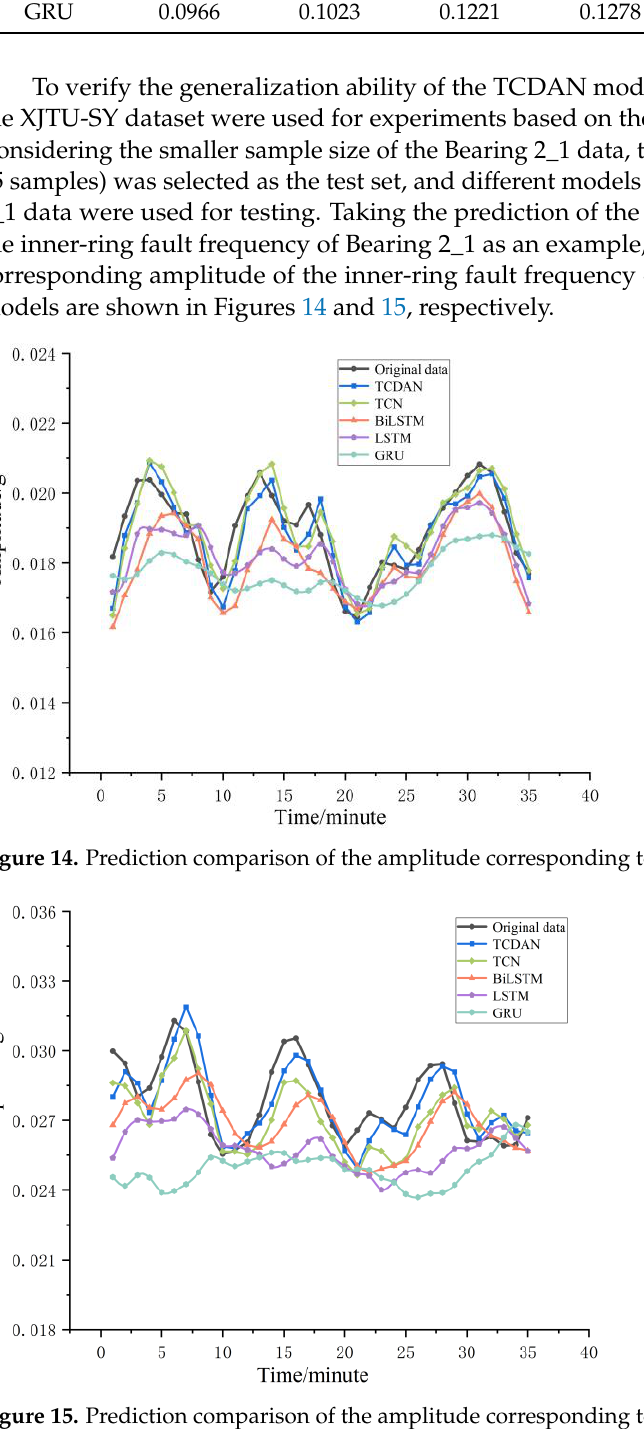
Figure 15. Prediction comparison of the amplitude corresponding to 2 × fi.